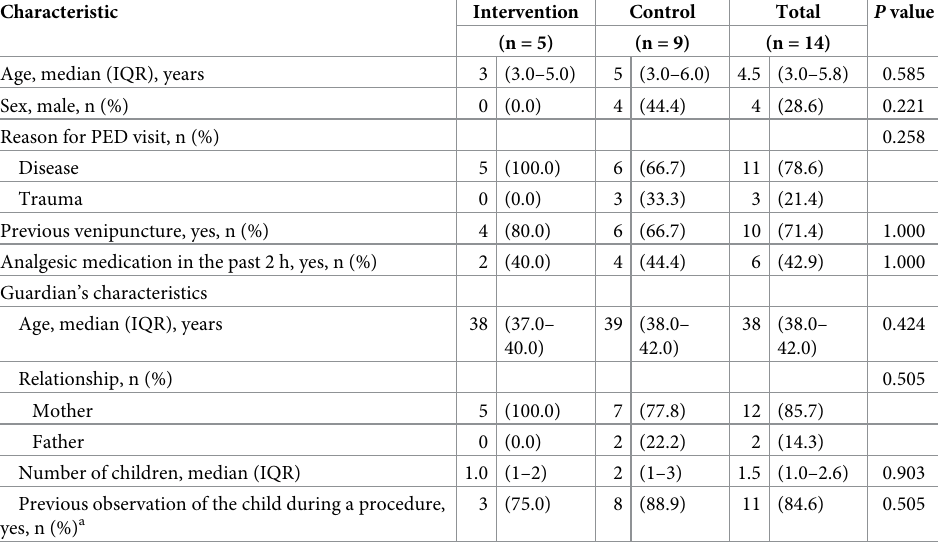
Table 1. Baseline characteristics of the